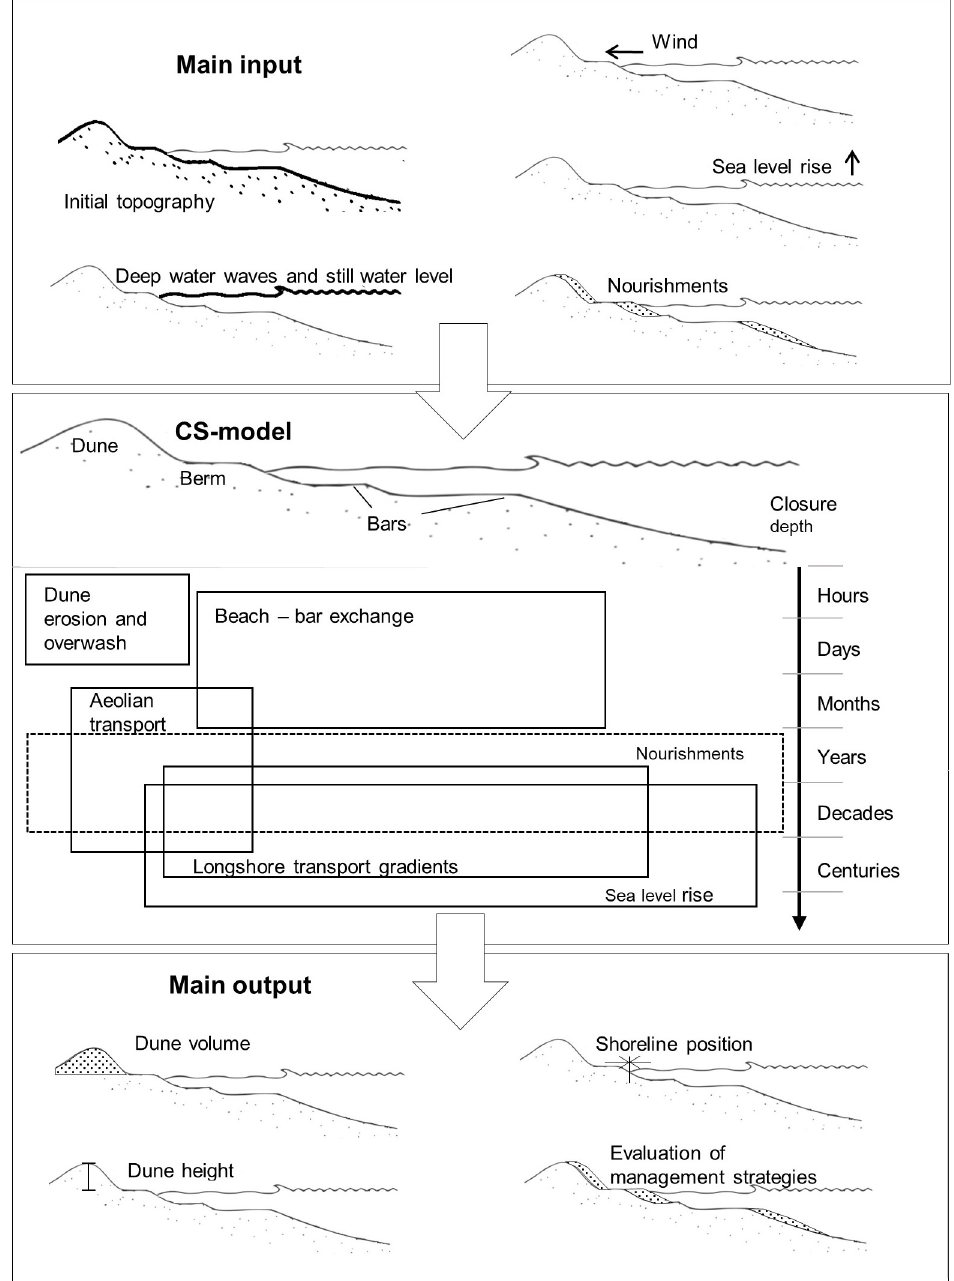
Fig 1. Conceptual model of decadal to centennial scale beach and dune